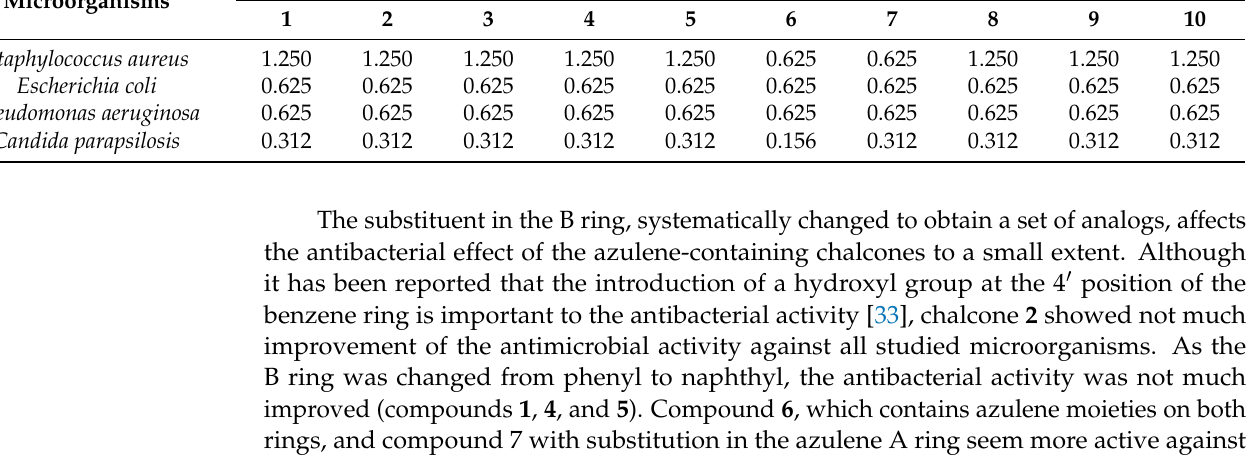
Table 5. Antibacterial and antifungal activities of azulene ‐ containing chalcones 1 – 10 . Microorganisms